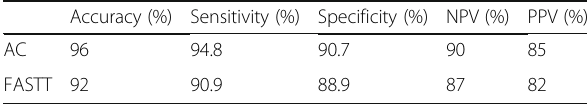
Table 4 The diagnostic value of AC and FASTT as predictor for fetal